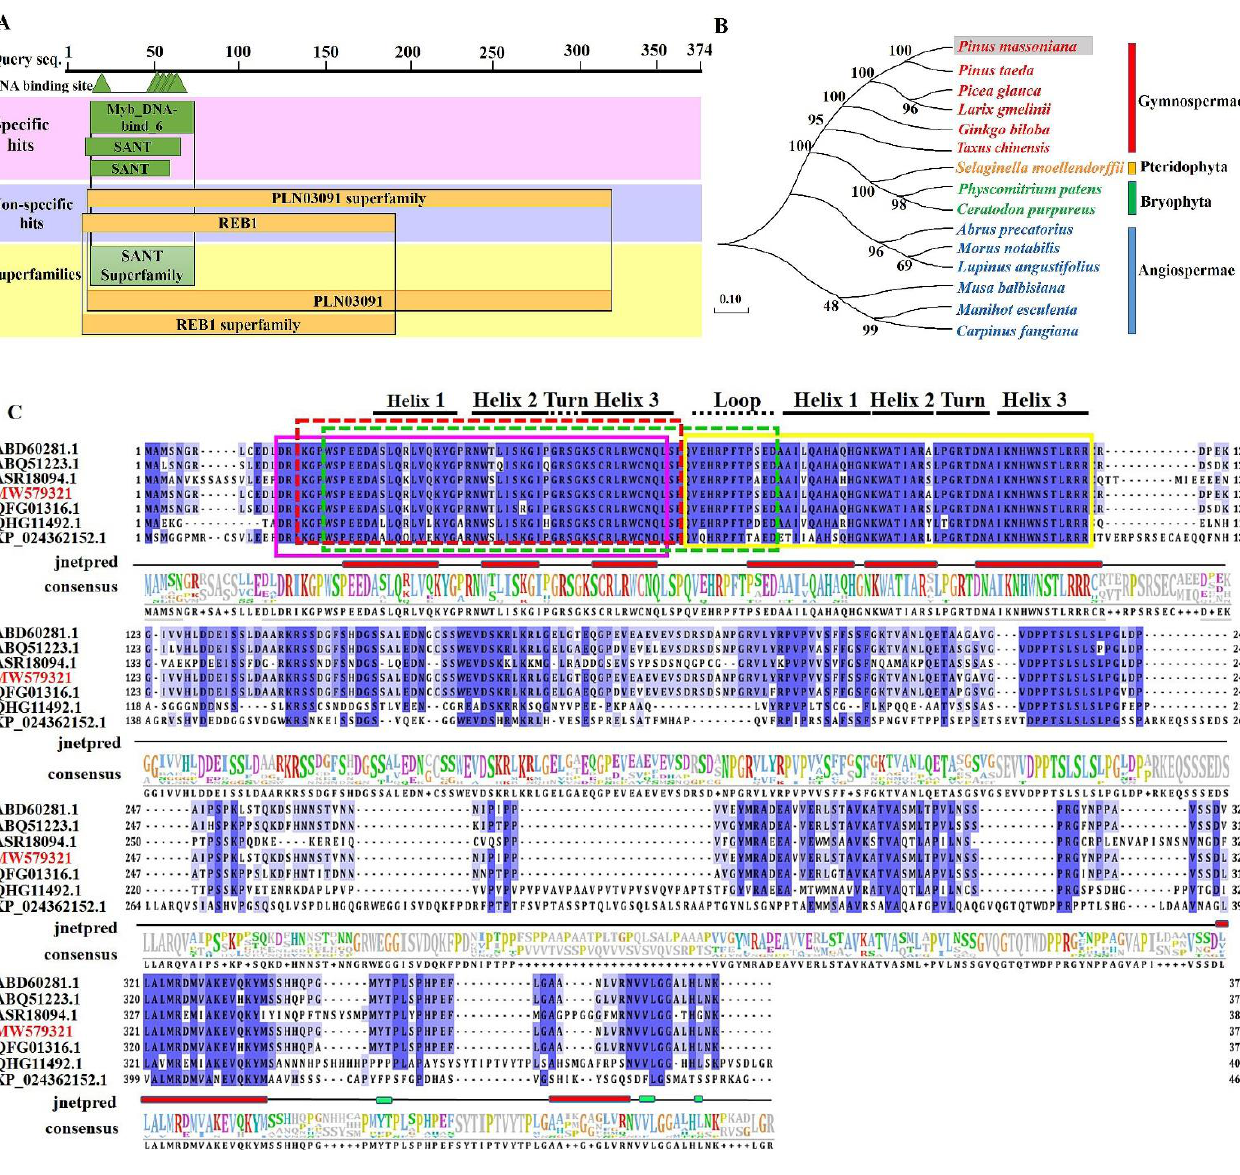
Figure 2. Structural features and phylogenetic analysis of the PmMYB7 protein. ( A ) Structure of the PmMYB7 protein. ( B ) Phylogenetic analysis of PmMYB7 with R2R3-MYB TFs. Red represents Gymnospermae, yellow Pteridophyta, green Bryophyta, and blue Angiospermae. P. massoniana in gray shadow represents PmMYB7. The GenBank accession numbers are as follows: P. taeda (ABD60281.1), Picea glauca (ABQ51223.1), Larix gmelinii (QFG01316.1), Ginkgo biloba (ASR18094.1), Taxus chinensis (QHG11492.1), Selaginella moellendorffii (XP_024536333.1), Physcomitrium patens (XP_024362152.1), Ceratodon purpureus (KAG0581796.1), Abrus precatorius (XP_027345753.1), Morus notabilis (XP_010095320.2), Lupinus angustifolius (XP_019444671.1), Musa balbisiana (THU58269.1), Manihot esculenta (XP_021601648.1) and Carpinus fangiana (KAE8100124.1). ( C ) Amino acid sequence alignment of PmMYB7 from P. massoniana and other plants. The R2 domain is indicated by a pink box, and the R3 domain by a yellow box. “jnetpred” in the picture represents the predicted secondary structure of the MYB7 protein: α -helices are represented by red tubes, and β -sheets are represented by green tubes. The MYB-binding domain is indicated by a green dotted line box. The SANT domain is indicated by a red dotted line box. MW579321 in red represents